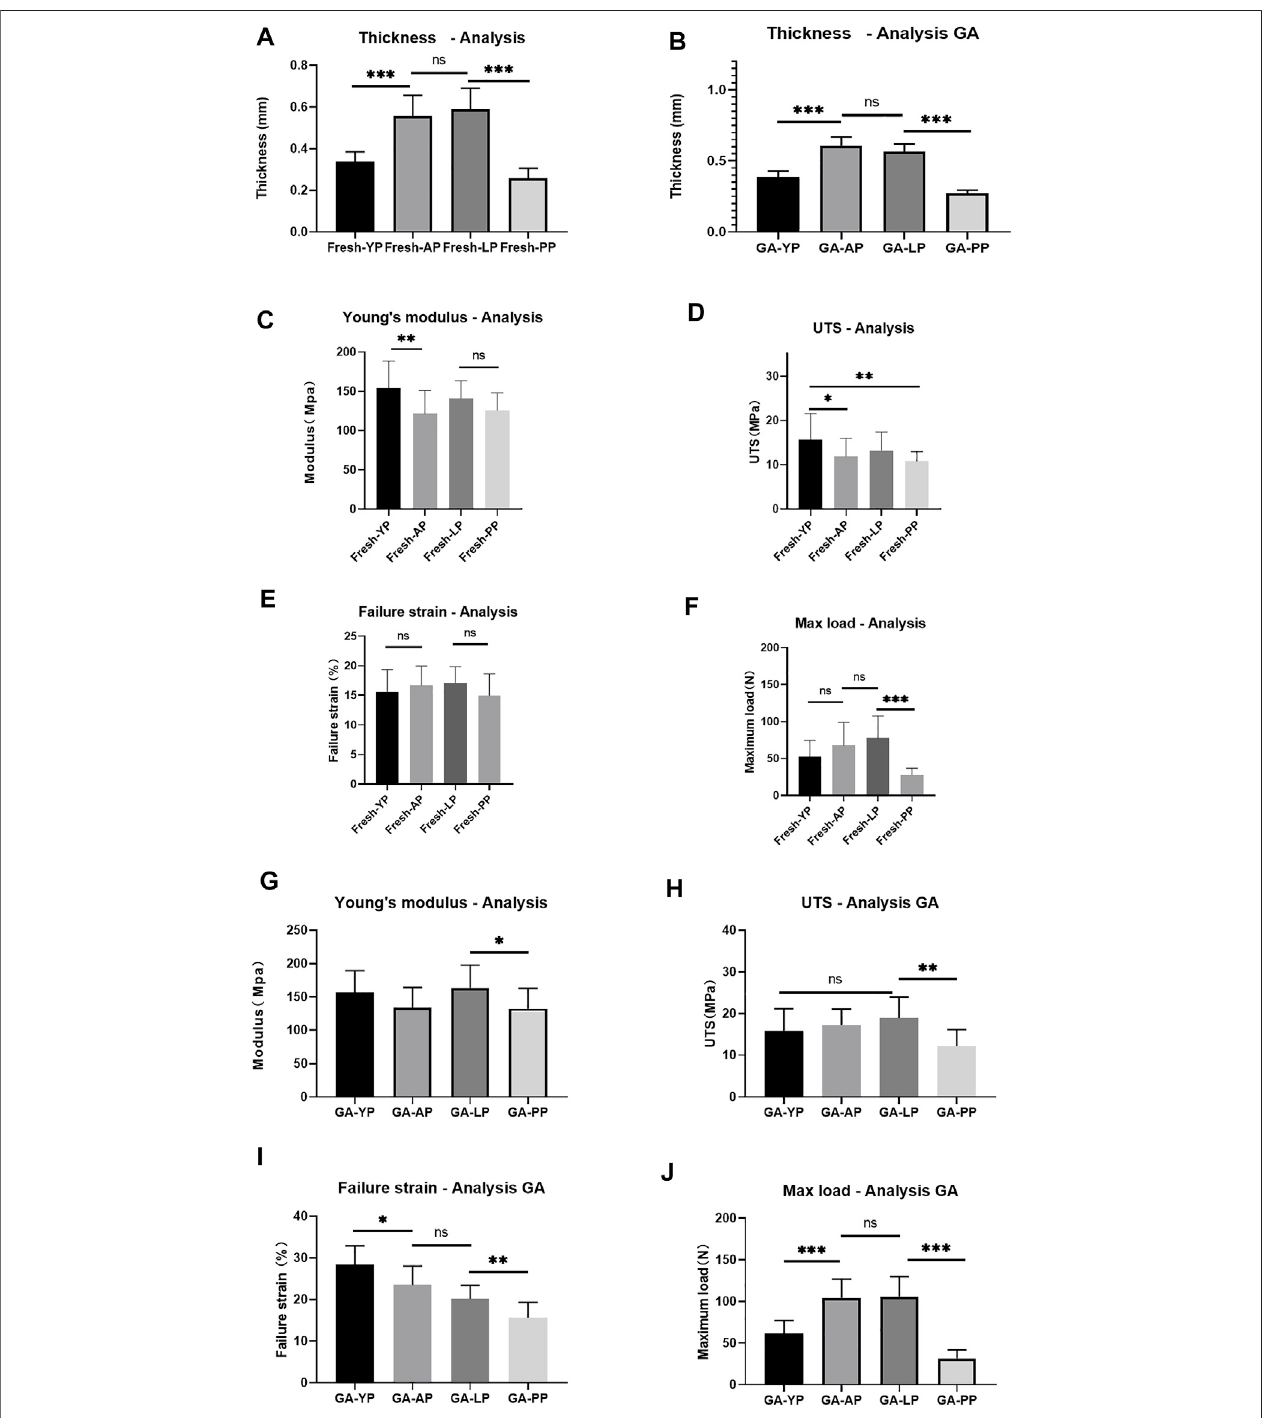
FIGURE 5 | (A) , Detect the thickness of fresh pericardium. (B) , Detect the thickness of GA-crosslinked pericardium. ( n (cid:2) 12; * p < 0.05; ** p < 0.01;*** p < 0.001; ns represents no signi fi cant difference). Mechanical performance of fresh yak pericardium (Fresh-YP), fresh Australian bovine pericardium (Fresh-AP), fresh local bovine pericardium (Fresh-LP), and fresh porcine pericardium (Fresh-PP). (C) , Young ’ s modulus; (D) , The ultimate tensile strength (UTS). (E) , Failure strain; (F) , Max load. ( n (cid:2) 20;* p < 0.05;** p < 0.01;*** p < 0.001;nsrepresentsnosigni fi cantdifference)MechanicalperformanceofGA-crosslinkedyakpericardium(GA-YP),GA-crosslinked Australianbovinepericardium(GA-AP),GA-crosslinkedlocalbovinepericardium(GA-LP),andGA-crosslinkedporcinepericardium(GA-PP). (G) ,Young ’ smodulus; (H) , The ultimate tensile strength (UTS). (I) , Failure strain; (J) , Max load. ( n (cid:2) 10; * p < 0.05; ** p < 0.01;*** p < 0.001; ns represents no signi fi cant difference).